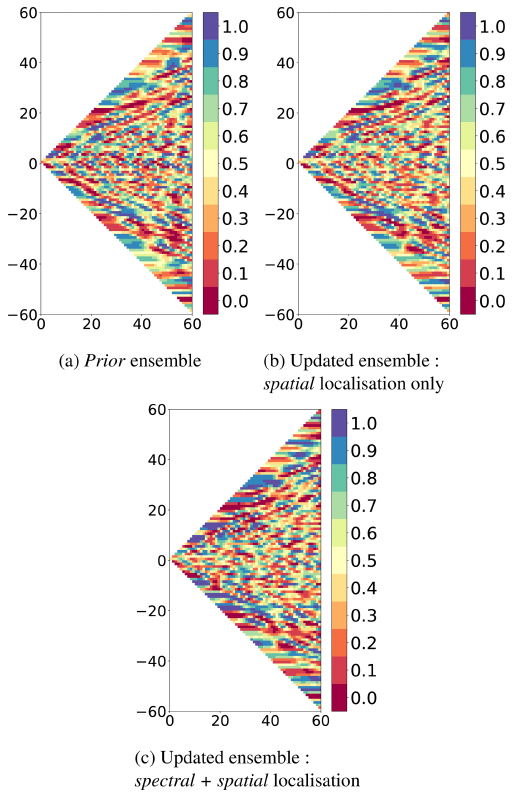
Figure 10. Maps of ranks in the spectral domain for the SSH, according to the degrees l ∈ [ 0 , 60 ] in the abscissa and m in the ordinate; see Eq. (2). (a) Prior ensemble; (b, c) updated ensem- bles, respectively, obtained after spatial localisation only (see Eq. 6) or after the multiscale analysis (spectral + spatial localisation; see Sect.